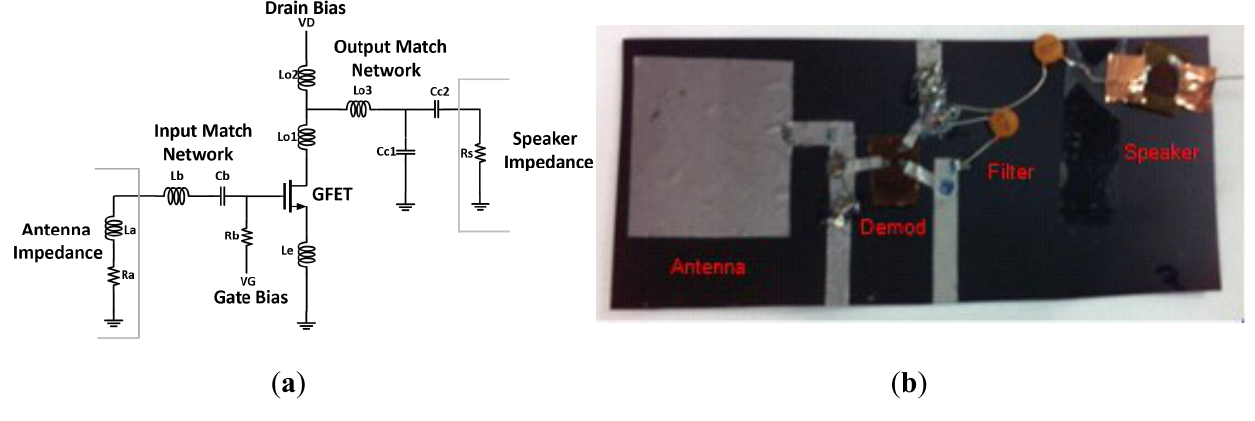
Figure 12. ( a ) Schematic of a graphene-based AM radio receiver; ( b ) Fabricated AM